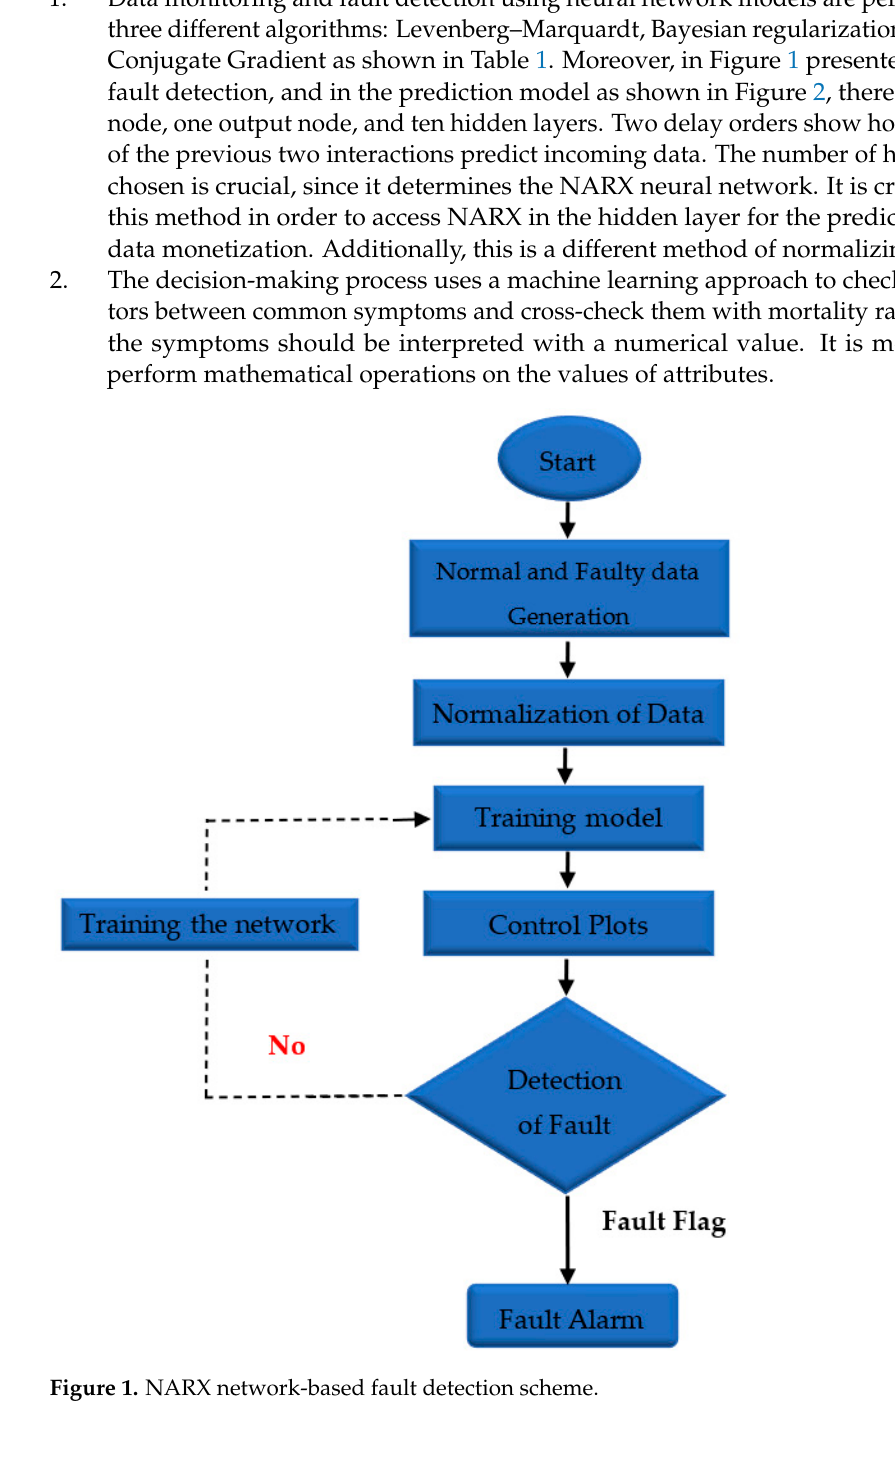
Figure 2. The NARX neural network model. 2. Related Work In this section, we discuss various background research on healthcare issues. For in- stance, AI models are considered for improving complex healthcare databases. 2.1. Transformation Managing healthcare records for various purposes and needs is a key way to create enriched data sets for analysis [27]. Accordingly, an AI methodology is used to assemble data from different sources that have been acknowledged as belonging to the same entity [28,29]. This data management could be carried out using deterministic and probabilistic approaches, depending on how they exist in the first place. This is because there are no common identifiable attributes within all of these data sources. Both of these concerns, these